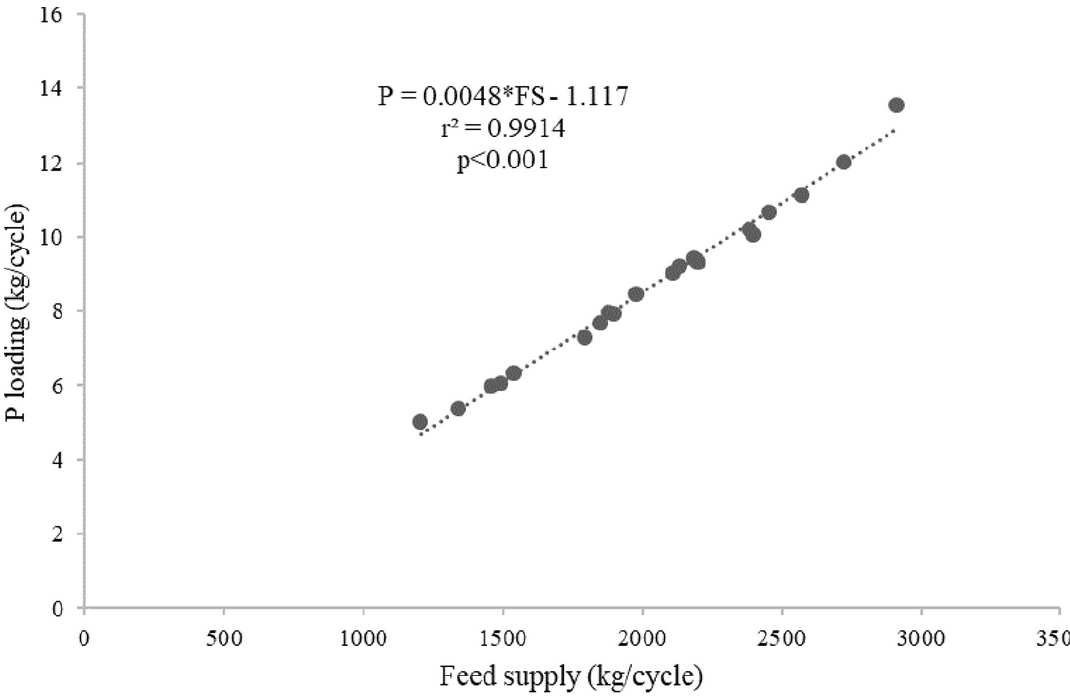
Figure 4. Feed supply and phosphorus loading relationship for giant gourami reared in floating